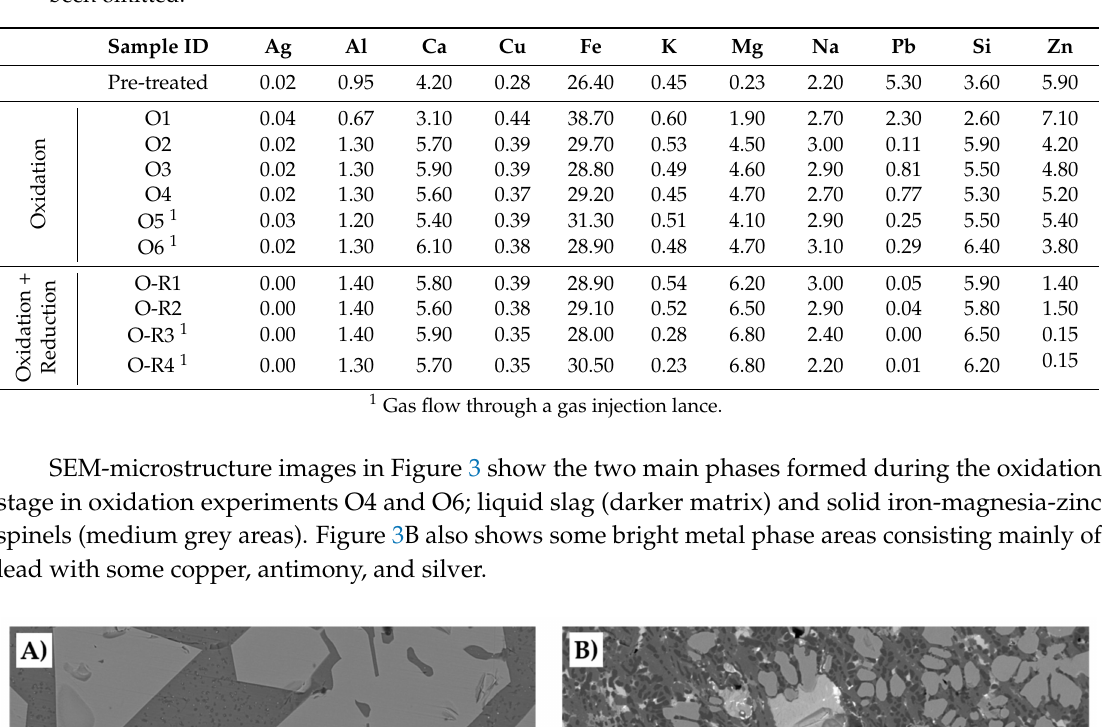
Table 2. Bulk compositions of the samples based on the chemical analysis results (wt %, rounded to two decimals). Oxygen concentration of the samples was not determined, and the trace elements have been omitted.